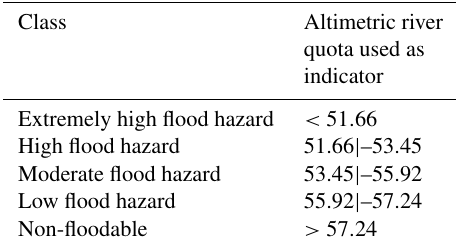
Table 5. Classes of flood hazard mapping in Itaqui, southern Brazil. Class